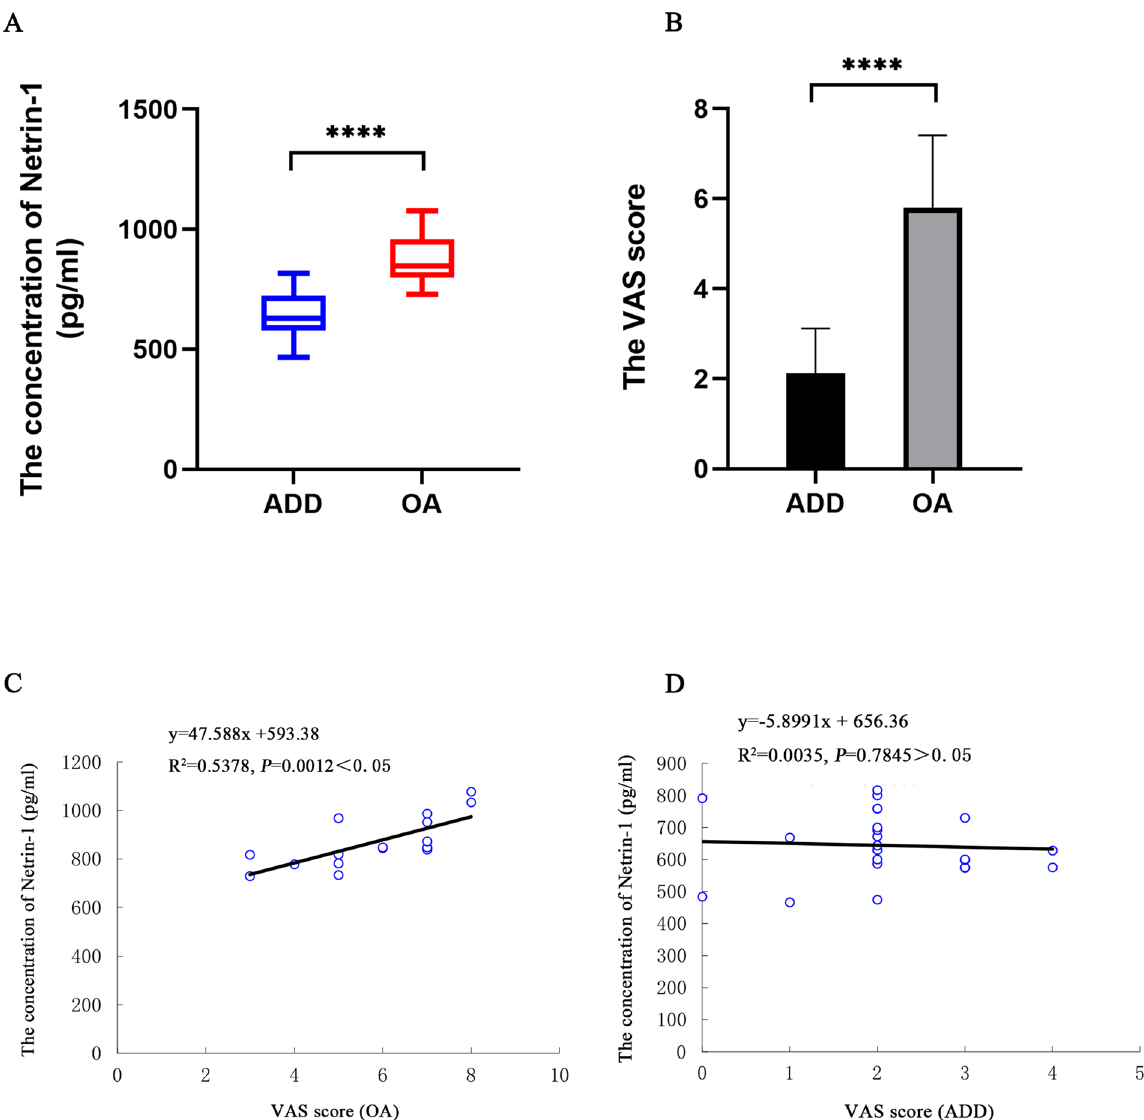
Figure 1. (A) The concentration of Netrin-1 in synovial fluid of human temporomandibular joint articular disc displacement (ADD) (n = 24) and osteoarthritis (OA) (n = 16) was measured by ELISA. (B) The VAS scores of patients with ADD and OA. Box plots, 25th and 75th percentiles; horizontal solid lines, medians; horizontal bars, minimum and maximum. (C) The correlation between the concentration of Netrin-1 in the synovial fluid of TMJ OA (n = 16) and the VAS scores. **** P <